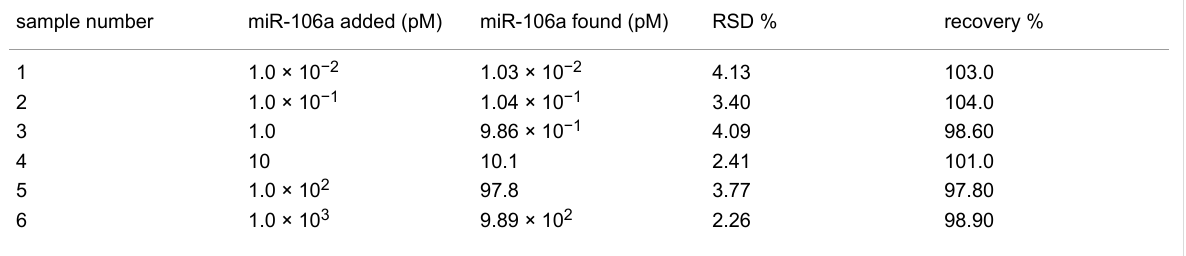
Table 1: Spike and recovery results obtained from miRNA-nanobiosensor in serum. Data are presented as the means of five replicates. sample number